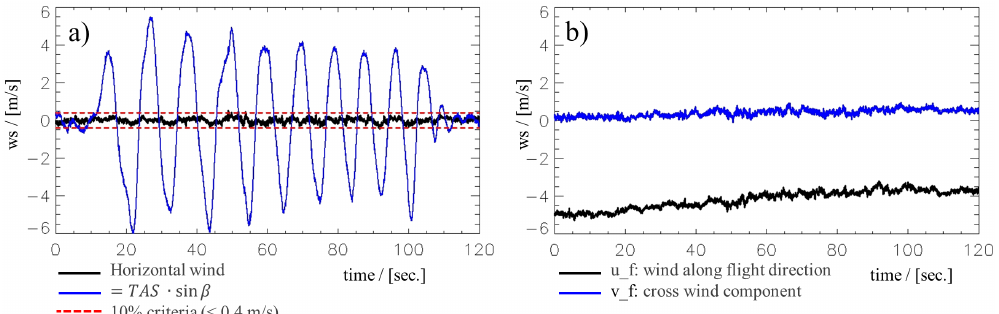
Figure 9. Results of the horizontal wind calculation during harmonic yaw oscillation. (a) shows the comparison of the horizontal wind with the induced cross-wind component. In order to point out the residual error due to the induced oscillation, the mean wind is removed. The criterion for an accurate calibration is that the residual error of the horizontal wind be less than 10% of the induced cross-wind component (e.g. TAS · sin β max ∼ 0.4ms − 1 ). In (b) the wind components along and perpendicular to the flight direction are drawn. The former is influenced by a possible error of the true airspeed and the latter of the sideslip